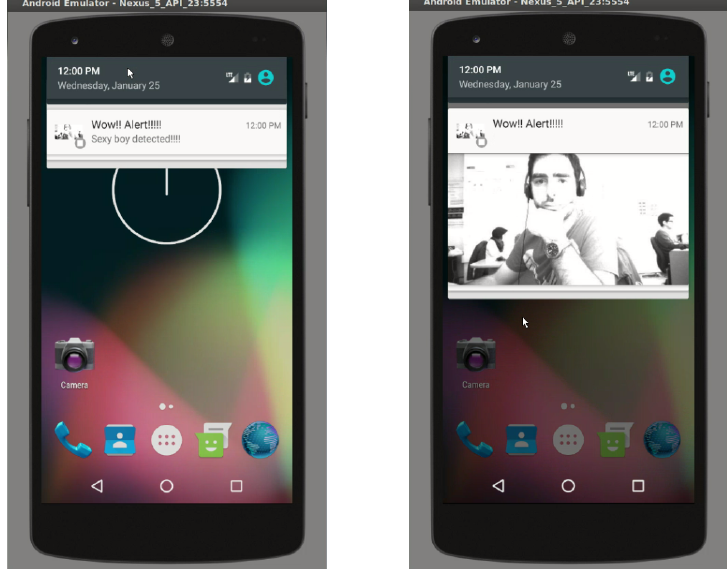
Figure 13. Push notification received on an Android smartphone. Left: prior to the user opening it; right: after touching on the